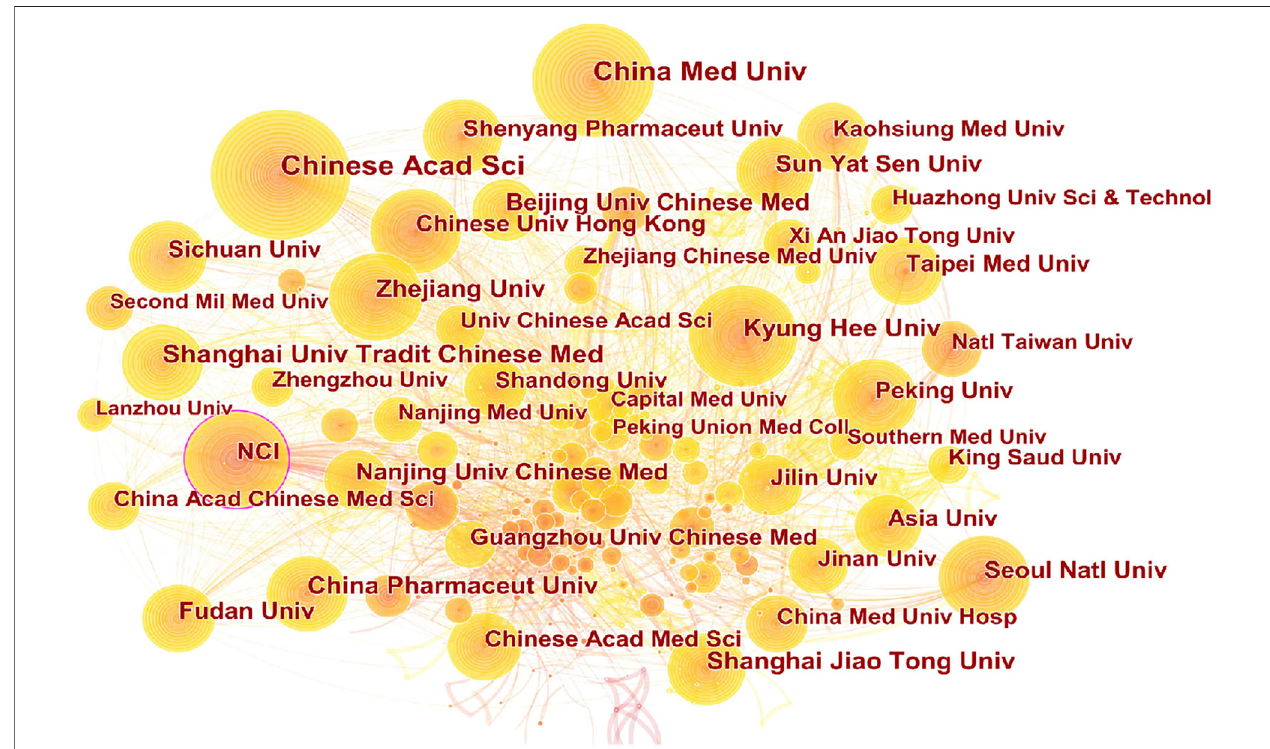
FIGURE 9 | Cooperation network of scienti fi c research institutions. Chinese Academy of Sciences ranks fi rst in the number of articles published; the National Cancer Institute of the United States (NCI) has the highest centrality. The size of the nodes represents the number of articles published by the scienti fi c research institutions, the lines between the nodes represent the cooperative relationship, and the thickness of the lines represents the co-occurrence strength. The larger the node, the greater is the number of articles. Nodes with centrality greater than 0.1 are marked with a purple outer circle.